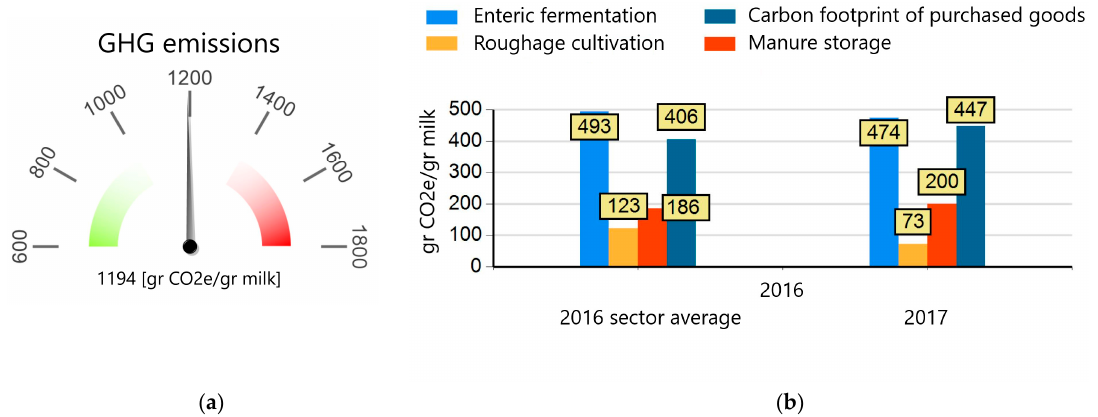
Figure 3. Example of the results dashboard showing ( a ) total greenhouse gas (GHG) emissions in